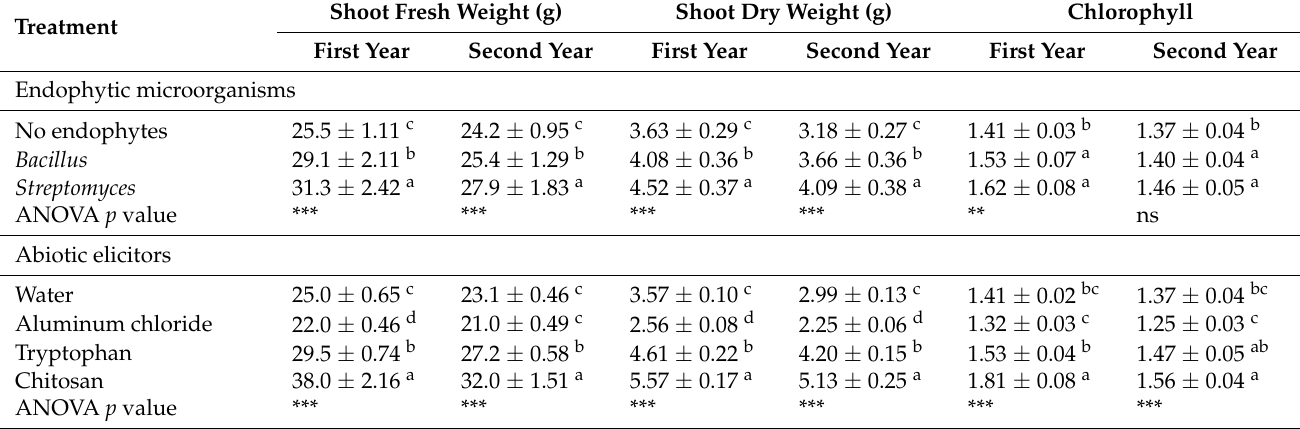
Table 1. Effect of endophytic microorganisms and abiotic elicitors on shoot fresh and dry weight (g); as well as chlorophyll concentration (mg g − 1 FW) in periwinkle plant shoot in both seasons. Means of five replicates are presented with ±